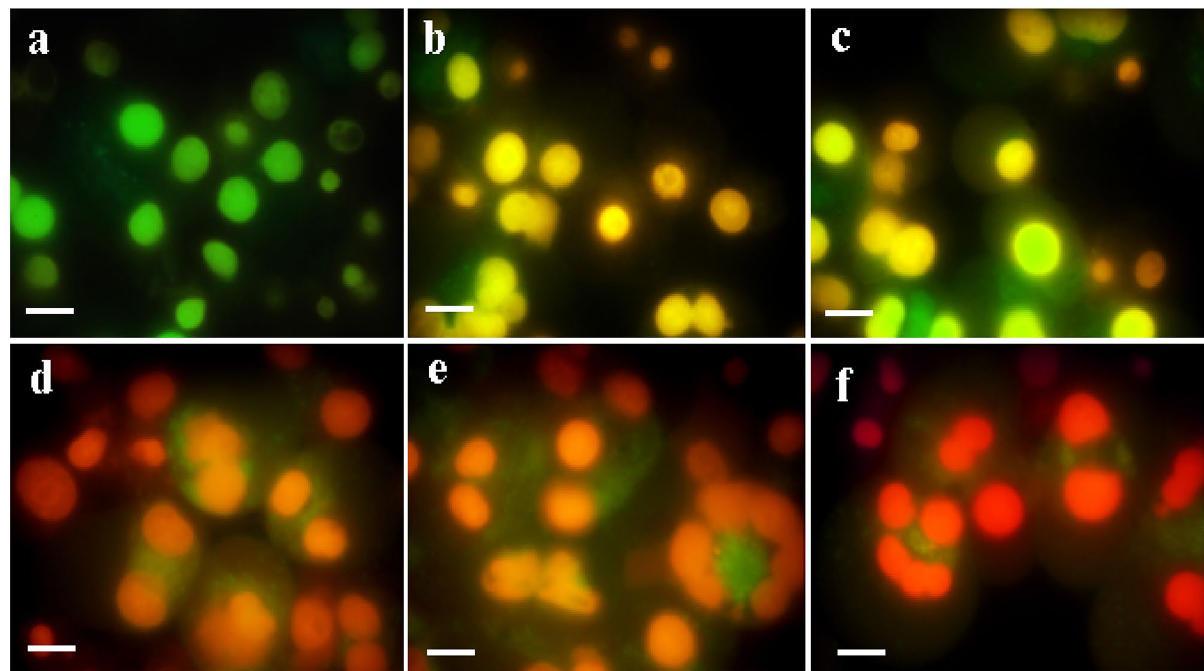
Figure 8. Cell growth inhibition of Hep-G2 cell lines treated with synthesized ZnO NPs. Apoptotic analysis of synthesized nanomaterials on HepG2 cells under fluorescence microscopy ( a ) control; ( b ) 12.5 μg/mL of ZnO